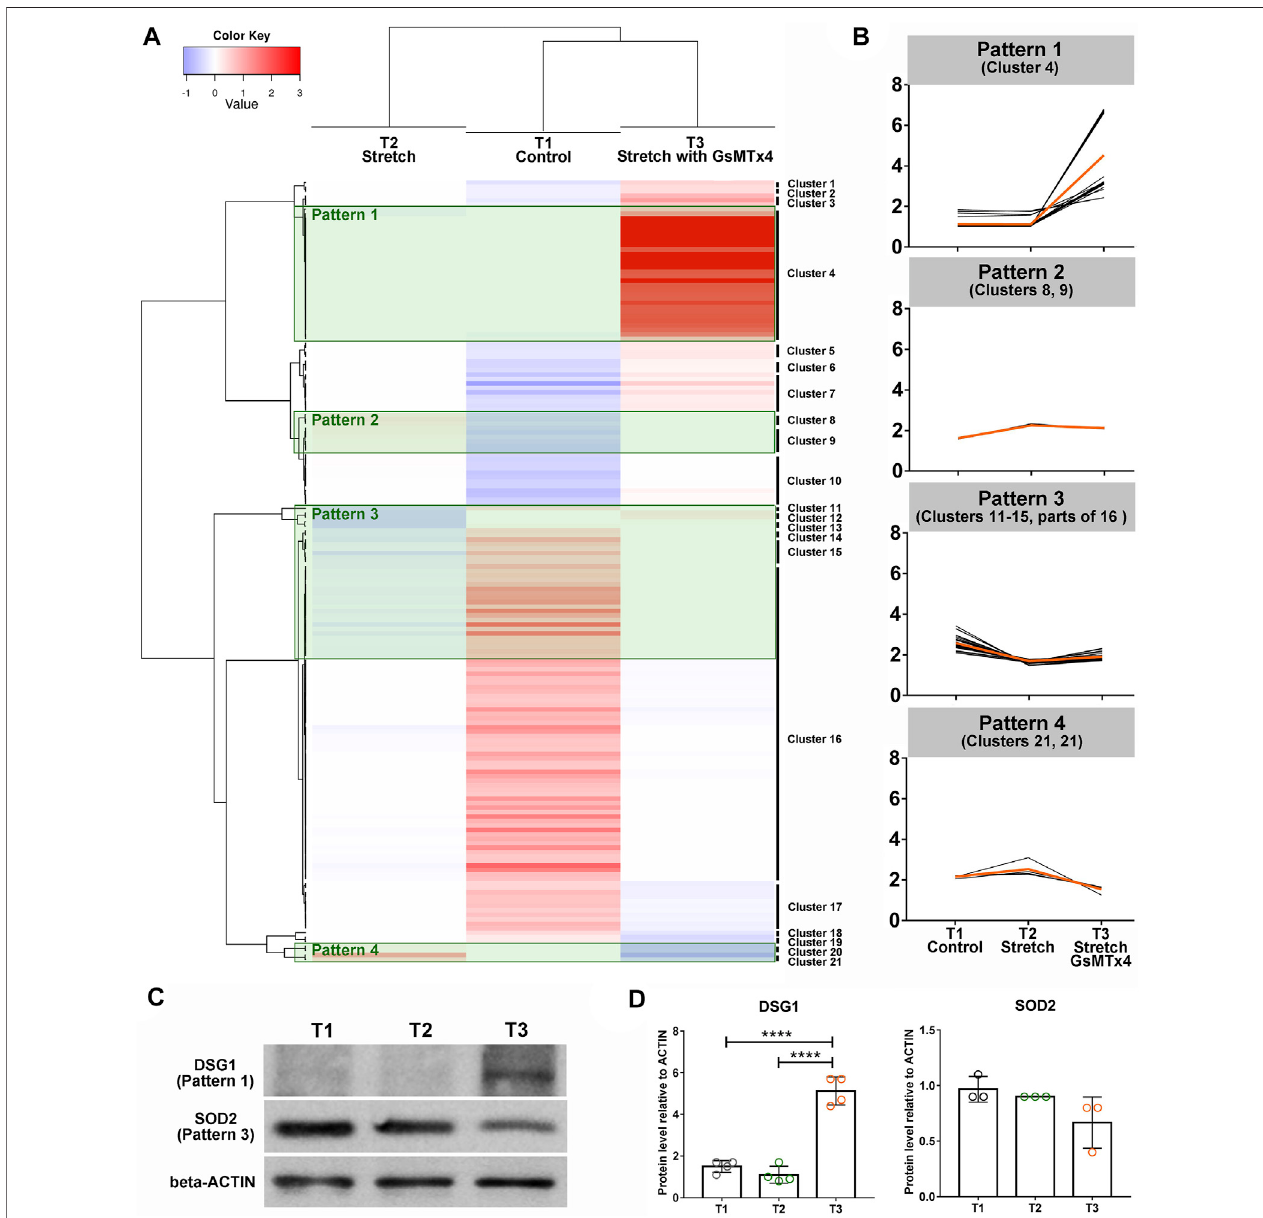
FIGURE 3 | Heatmap analysis using DEPs. 148 DEPs (109 DEPs in T2 vs. T1 and 39 DEPs in T3 vs. T2) are grouped into 21 clusters (A) . Four speci fi c patterns indicatingthepositiverolesofCMCsinthisprocessareshown (B) .TheorangelineindicatestheaverageofDEPs ’ expressionchangesineachgroup,whiletheblackline denotes the expression of each DEP. (C) . Western blot analysis of DSG1 as a representative of Pattern 1, SOD2 as a representative of Pattern 3 (top) and beta-Actin (bottom) in T1, T2, and T3. (D) . Quanti fi cation of band intensities using Image Lab software (Bio-Rad). **** p < 0.0001 by One-way ANOVA.